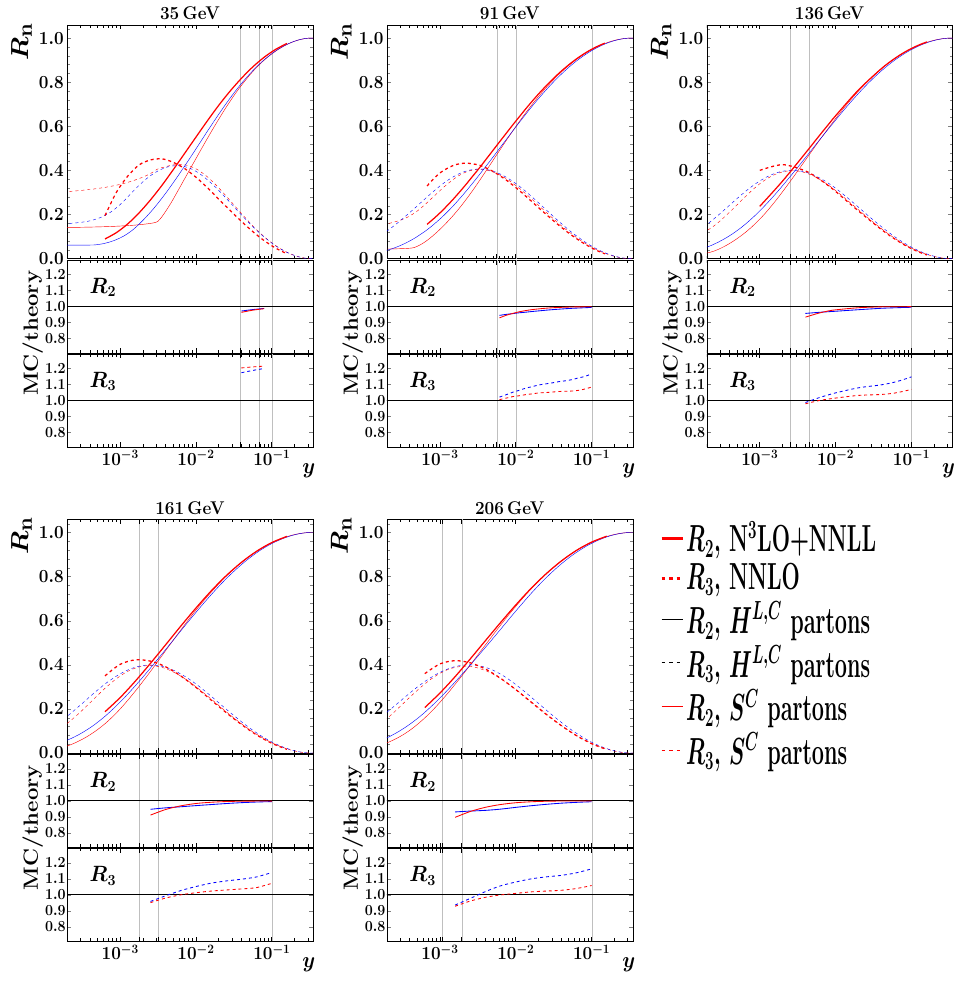
Figure 8 . Selected predictions obtained with S C , H C and H L MC setups at parton level and theory predictions obtained with (cid:11) S ( M Z ) = 0 :